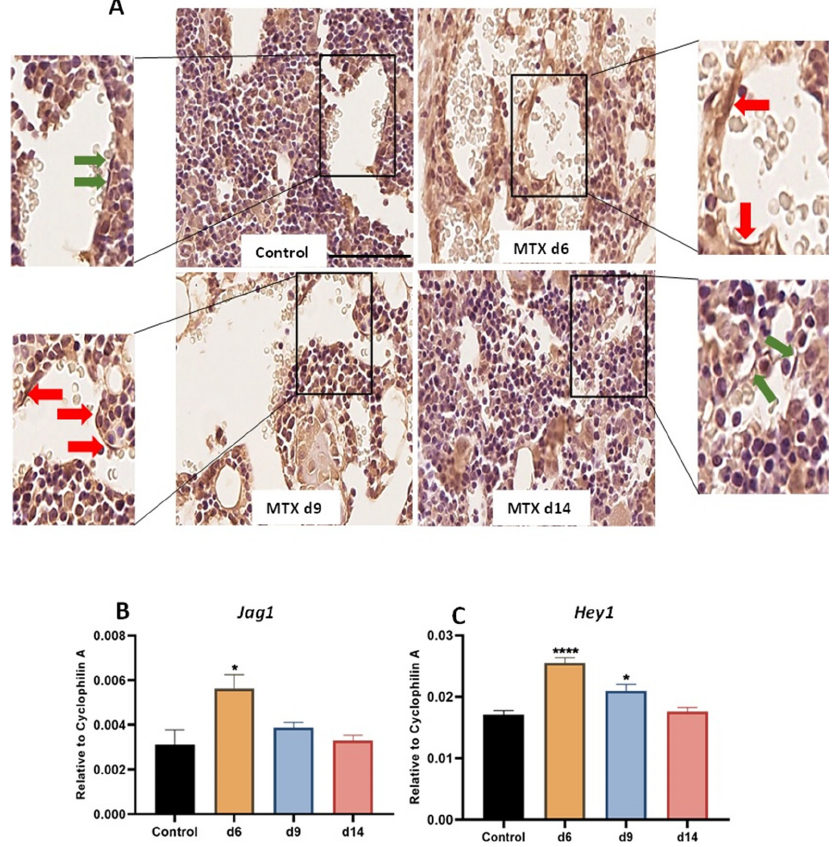
Figure 1. MTX chemotherapy-altered Notch2 intracellular domain (NICD2) protein level, Notch ligand Jag1 and Notch target gene Hey1 mRNA expression levels in tibial metaphysis bones. ( A ) Immunohistochemistry staining against NICD2 in tibial secondary spongiosa revealed more abundant NICD2-positive bone marrow endothelial cells (BMECs) (pointed by red arrows) at days (d) 6 and 9 (after the first MTX injection) compared to the control, and more NICD2-negative endothelial cells (pointed by green arrows) at day 14. Scale bar is 50 µ m. Quantification real time PCR analyses (using RNA isolated from metaphyseal bone specimens) for ( B ) Notch ligand Jag1 and ( C ) Notch target gene Hey1 . * p < 0.05 and **** p < 0.0001 compared with the control